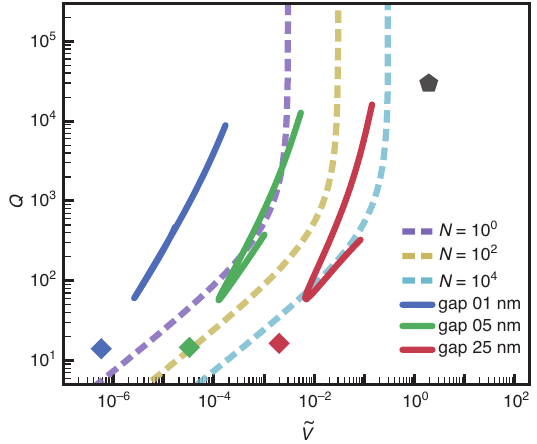
Figure 6: Strong coupling conditions for ensembles of emitters, at different emitter numbers N